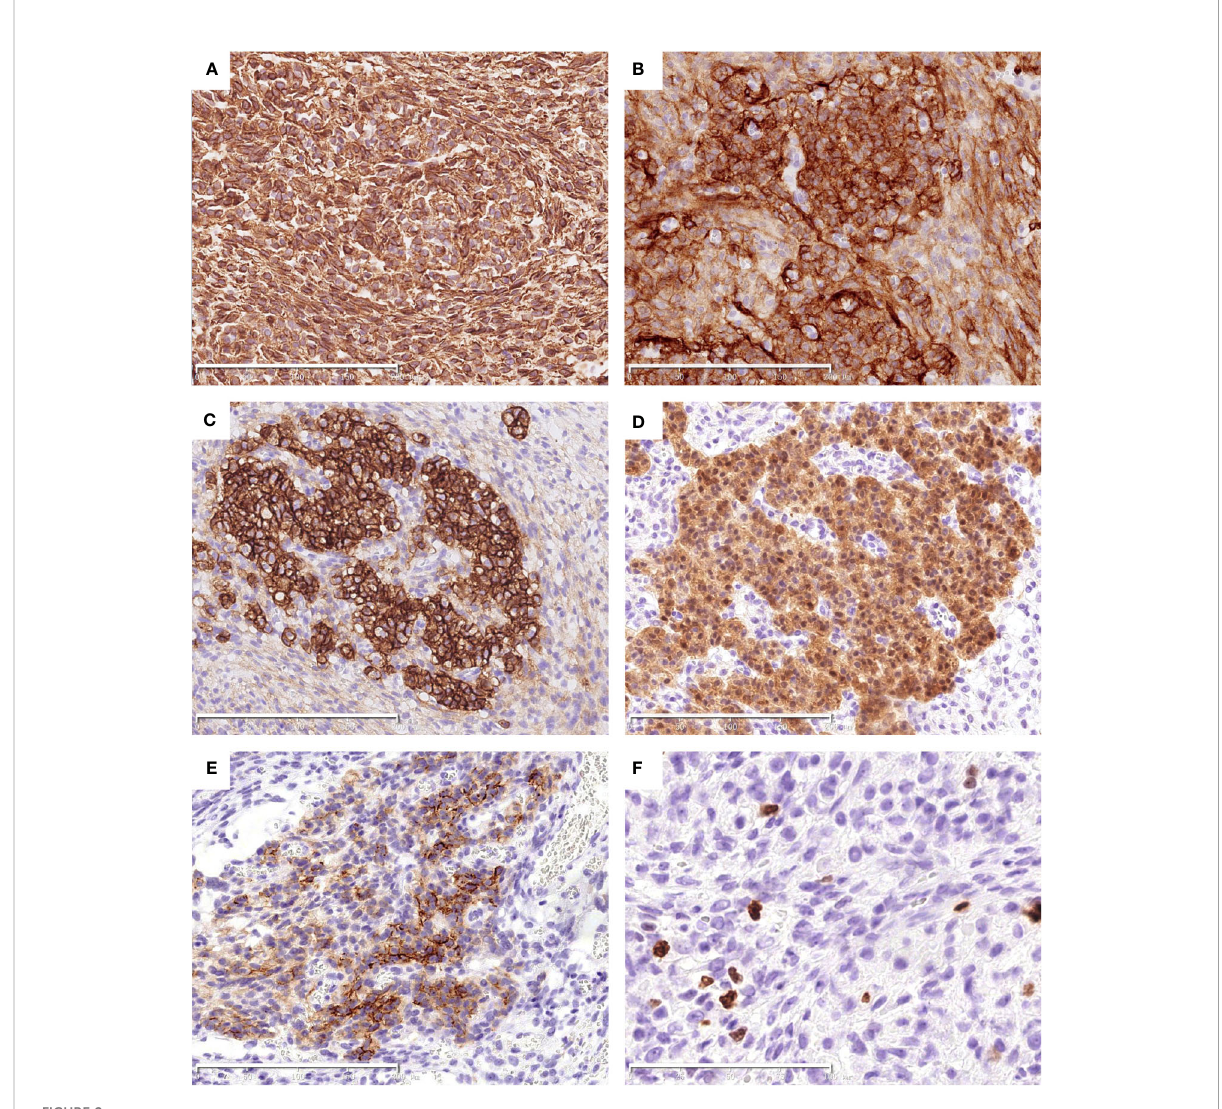
FIGURE 2 Immunohistochemical fi ndings of the tumor. Both the epithelial and spindle cell components diffusely express Vimentin (A) and CD10 (B) . The epithelial cells are strongly positive for CD56 (C) and S100 (D) , and focally positive for EMA (E) . The Ki-67 index was low (F) . The scale bars (200 m m in A – E , 100 m m in F